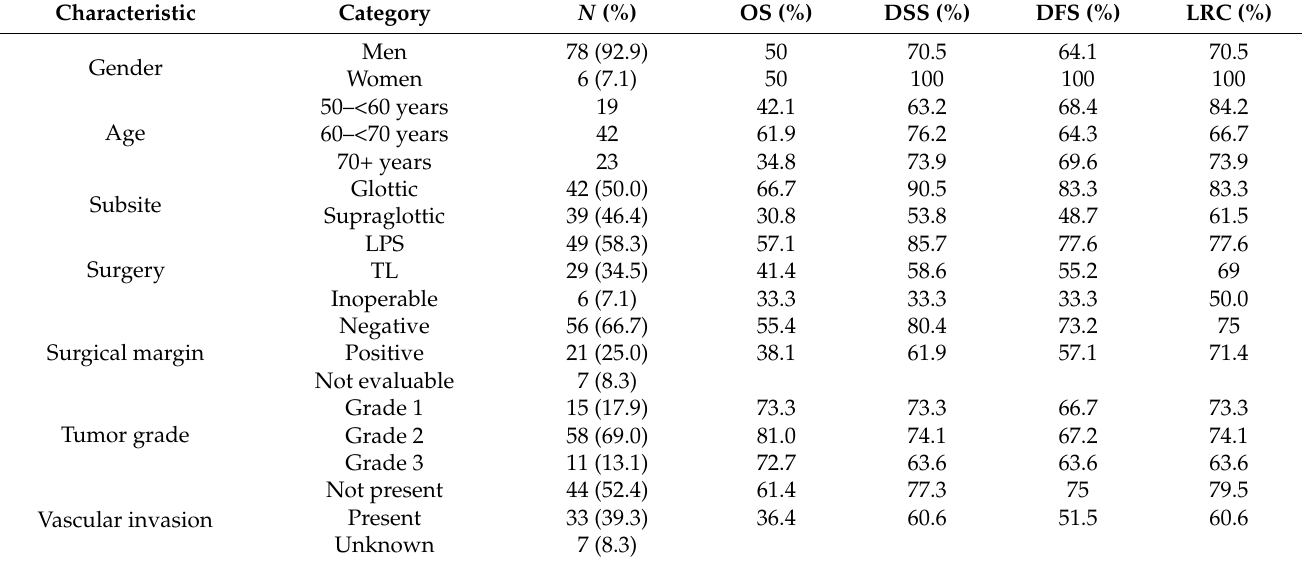
Table 1. Clinicopathological characteristics and survival rates for all patients ( N =